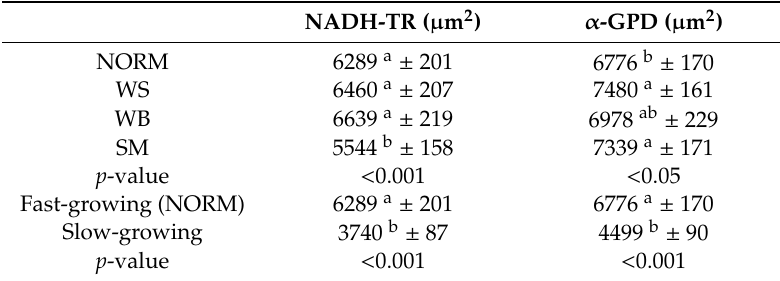
Table 2. Cross-sectional area (CSA) of the fibers stained for reduced nicotinamide adenine dinucleotide tetrazolium reductase (NADH-TR) or alpha-glycerophosphate dehydrogenase ( α -GPD) in pectoralis major muscles belonging to a fast-growing genotype exhibiting either macroscopically normal appearance (NORM) or a ff ected by white striping (WS), wooden breast (WB), or spaghetti meat (SM) abnormalities. The results obtained in fast-growing NORM muscles were also compared with those found in pectoralis major belonging to a slow-growing genotype. Values are expressed as mean ±